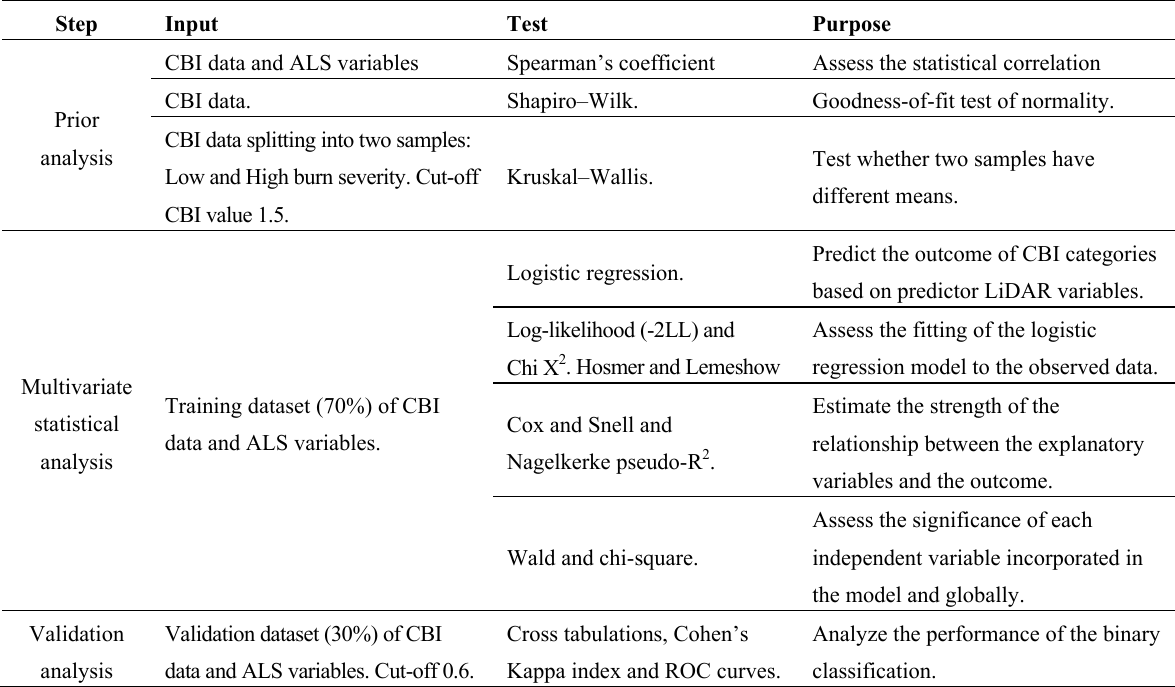
Table 4. Methodological steps performed to estimate the logistic regression model and its